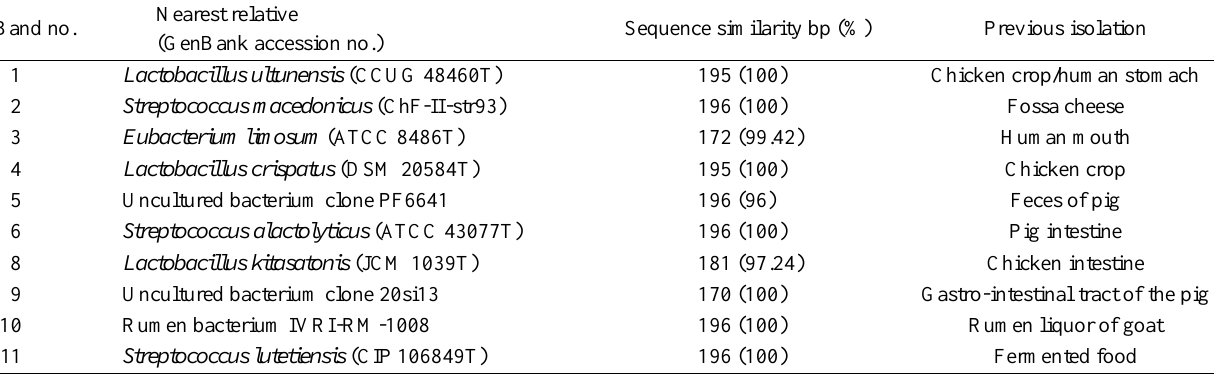
Table 4. Identified dominant bands from 16S rRNA DGGE amplified using total genomic DNA extracted from in vitro fermenta of swine fecal slurry added with different phytogenic feed additives Band no.